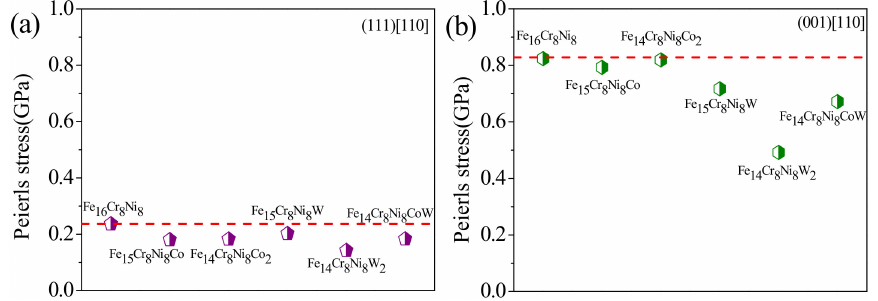
Figure 9. Calculated Peierls stresses of di ff erent systems: ( a ) (111) crystal plane and ( b ) (001) crystal